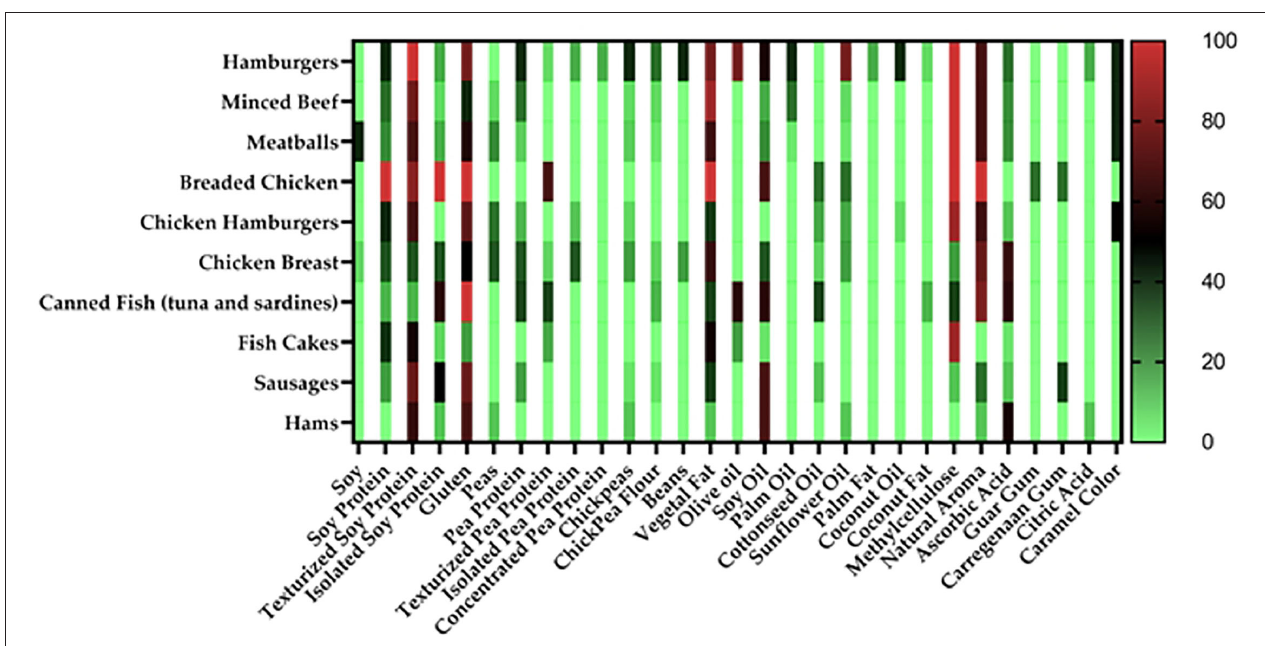
FIGURE 2 | Percentages of frequencies of implemented ingredients in vegan meat alternatives in a heatmap. Colored clusters represent different frequencies according to the scale placed on the right